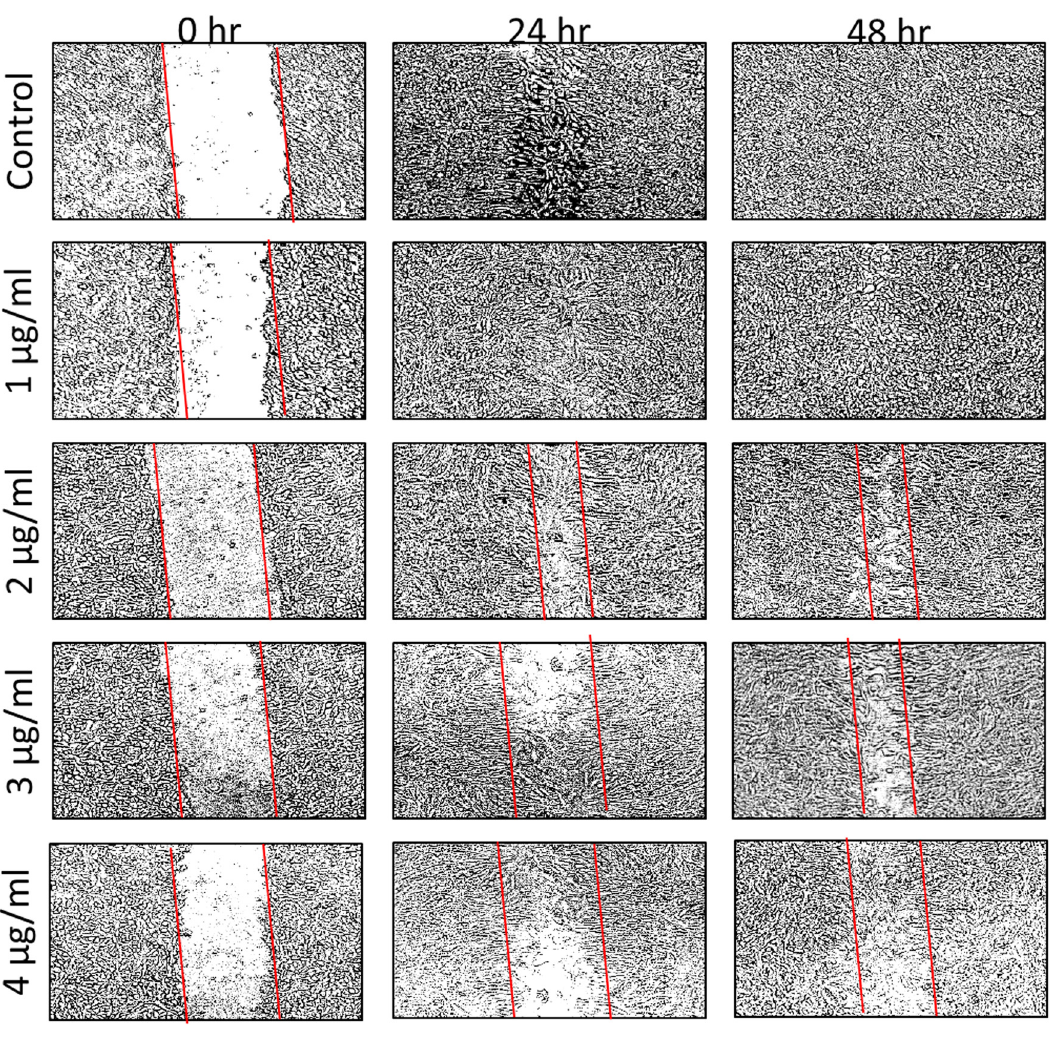
Figure 4: Scratch was applied to a monolayer of cells, which was then treated with 1 – 4 µg/mL AuNPs at various time intervals ( 0, 24, and 48 h ) . The number of cells that migrated to the scratch area, indicating metastatic inhibition, is visually displayed by outlining the scratch with parallel lines and visually exhibiting the number of cells that migrated to the scratch